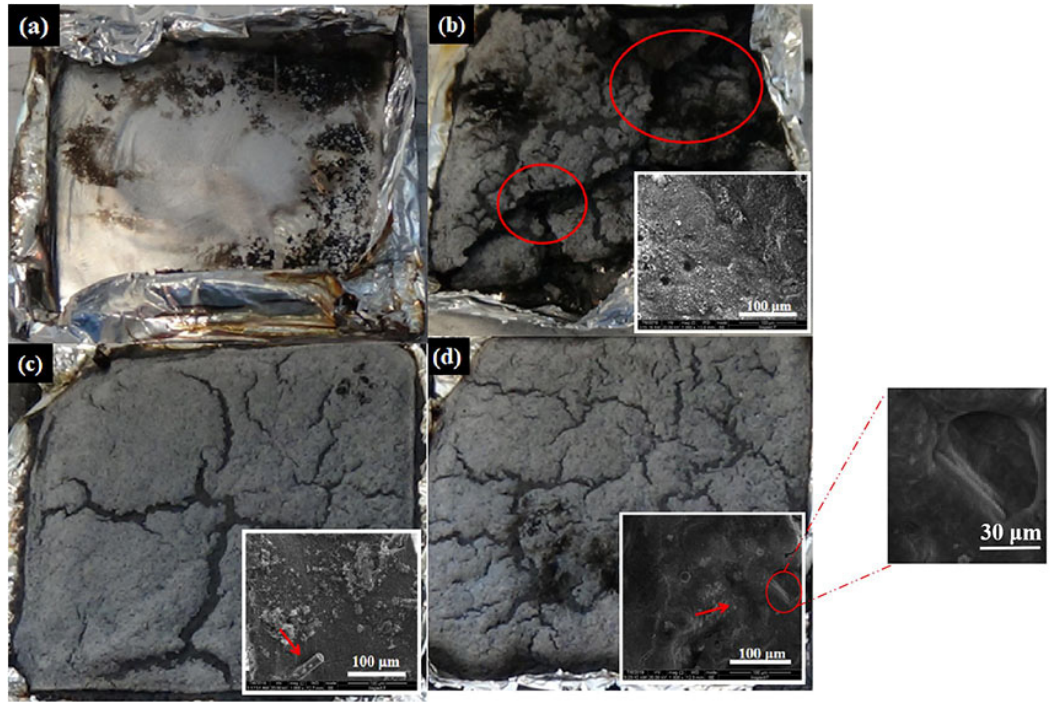
Figure 6. Digital photos and SEM photos of the char residue and its microphotographs of the external surface ( a – d ) of ( a ) EVA; ( b ) EVA/MH; ( c ) EVA/MH-PBF15; ( d ) EVA/MH-MBF15.